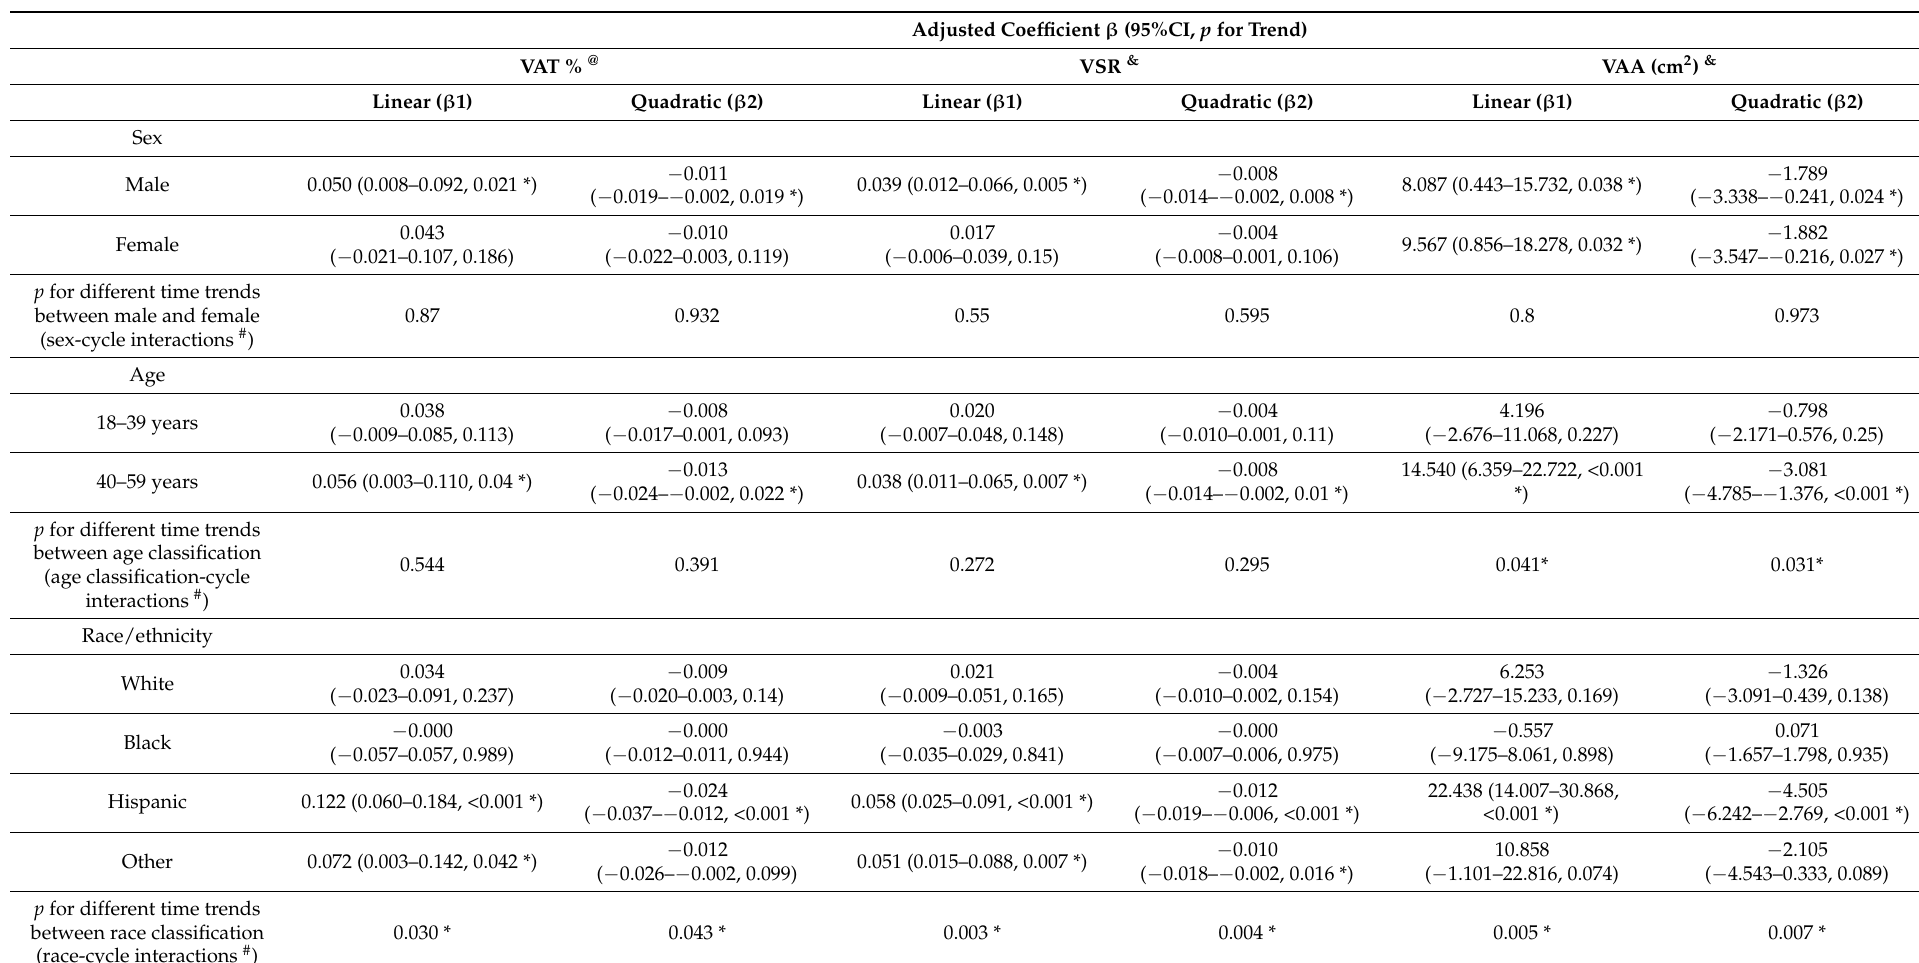
Table 3. The abdominal fat composition and distribution biennial change rate difference by demographics, NHANES